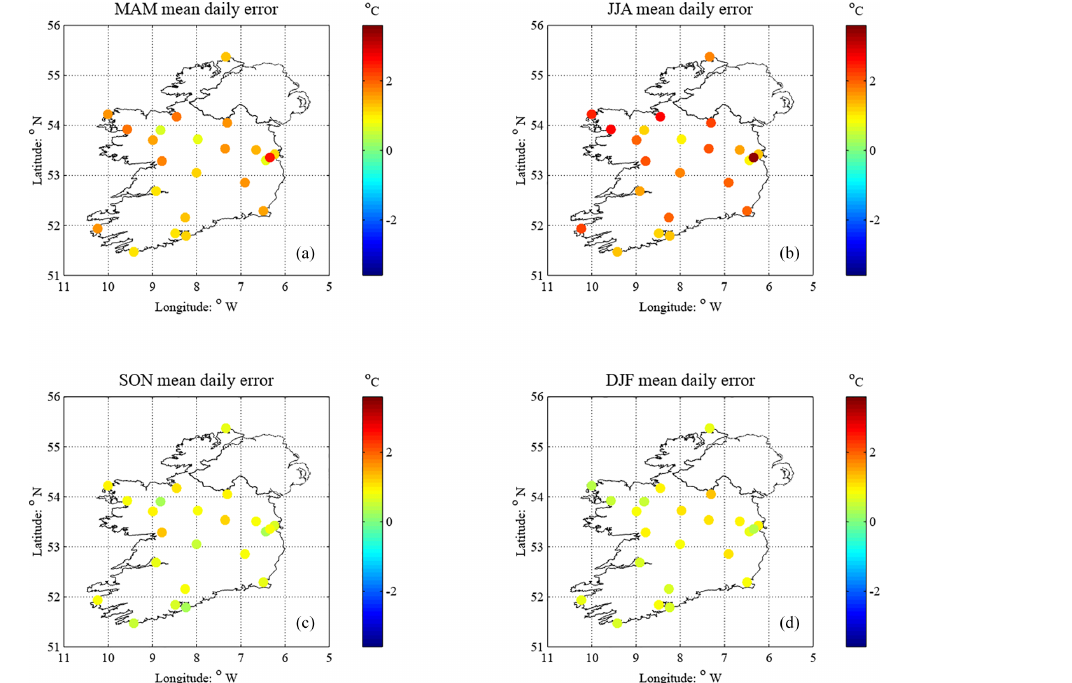
Figure 10. COSMO-CLM mean daily 10cm soil temperature error per season found through comparison with observations from 23 Met Éireann station data for: (a) Spring (MAM); (b) Summer (JJA); (c) Autumn (SON); (d) Winter (DJF).